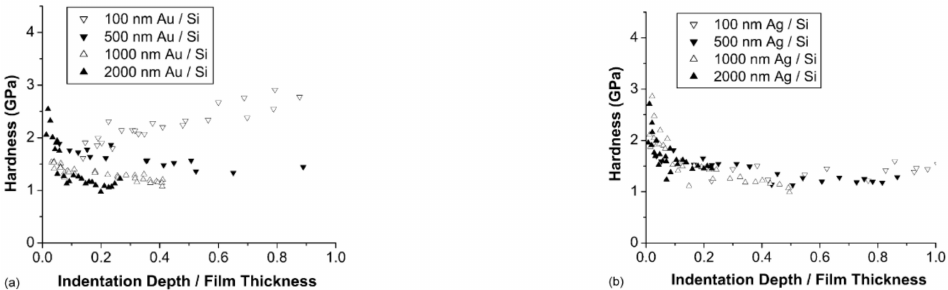
Figure 13. Hardness vs. normalized indentation depth for Au films in ( a ) and Ag films in ( b ). Reproduced with permission from Ref.